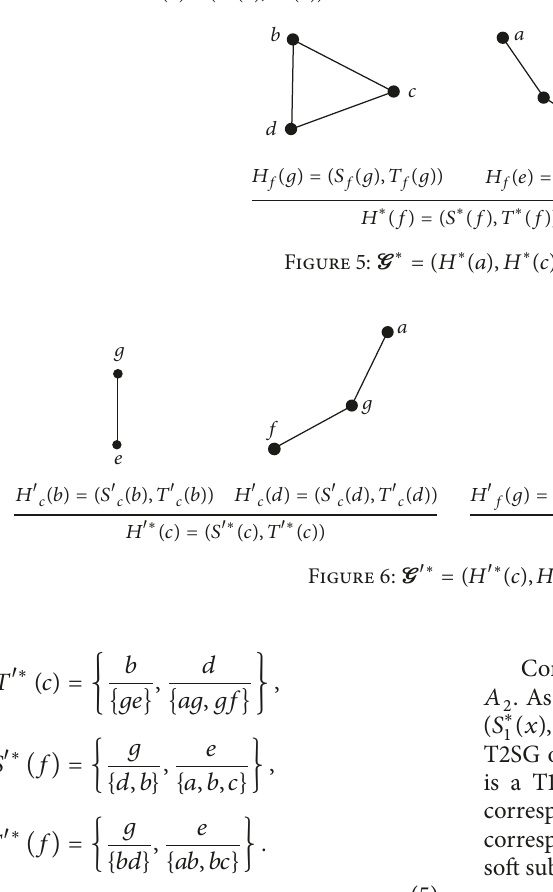
Figure 5: G ∗ = (𝐻 ∗ (𝑎),𝐻 ∗ (𝑐), 𝐻 ∗ (𝑓)) .